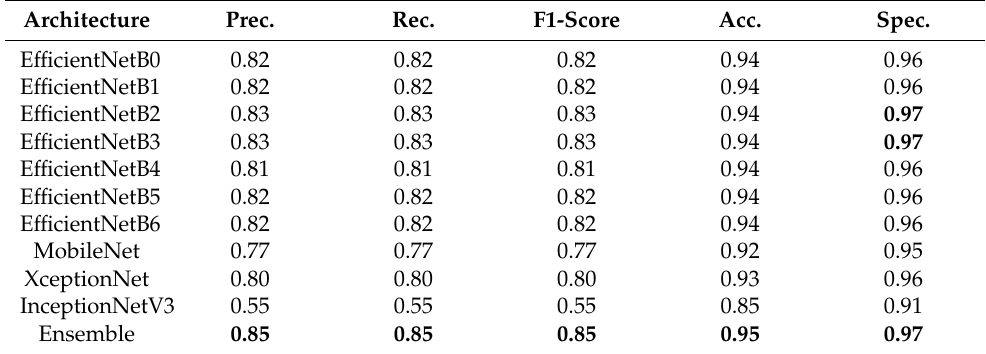
Table 7. Results for the six-class classification. The best results for each metric are highlighted in bold. Architecture Prec. Rec. F1-Score Acc.